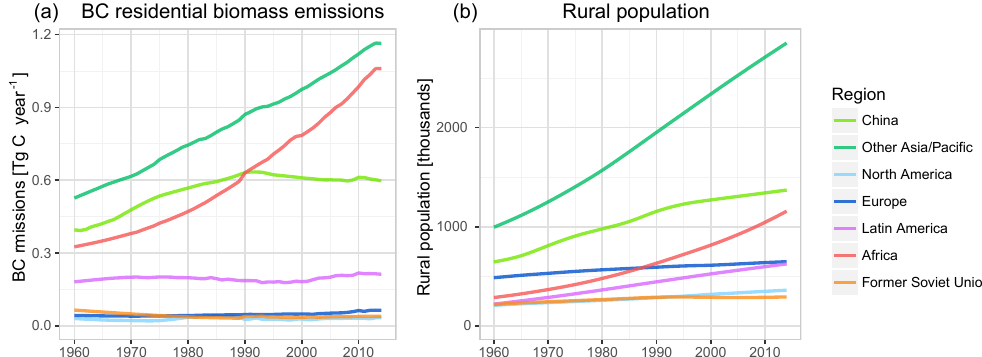
Figure 4. (a) BC residential biomass emissions by region and (b) rural population by